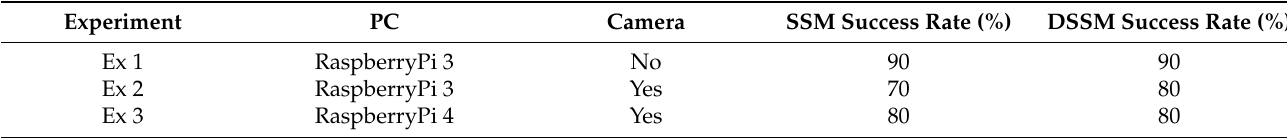
Table 7. Success rate of each experiment.